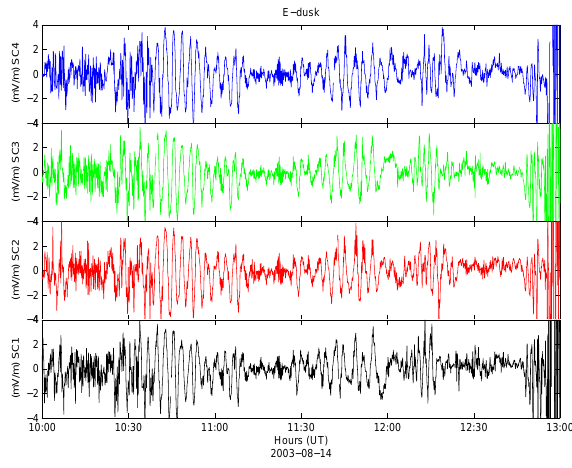
Fig. 6. The duskward electric field for the 14 August 2003 event.